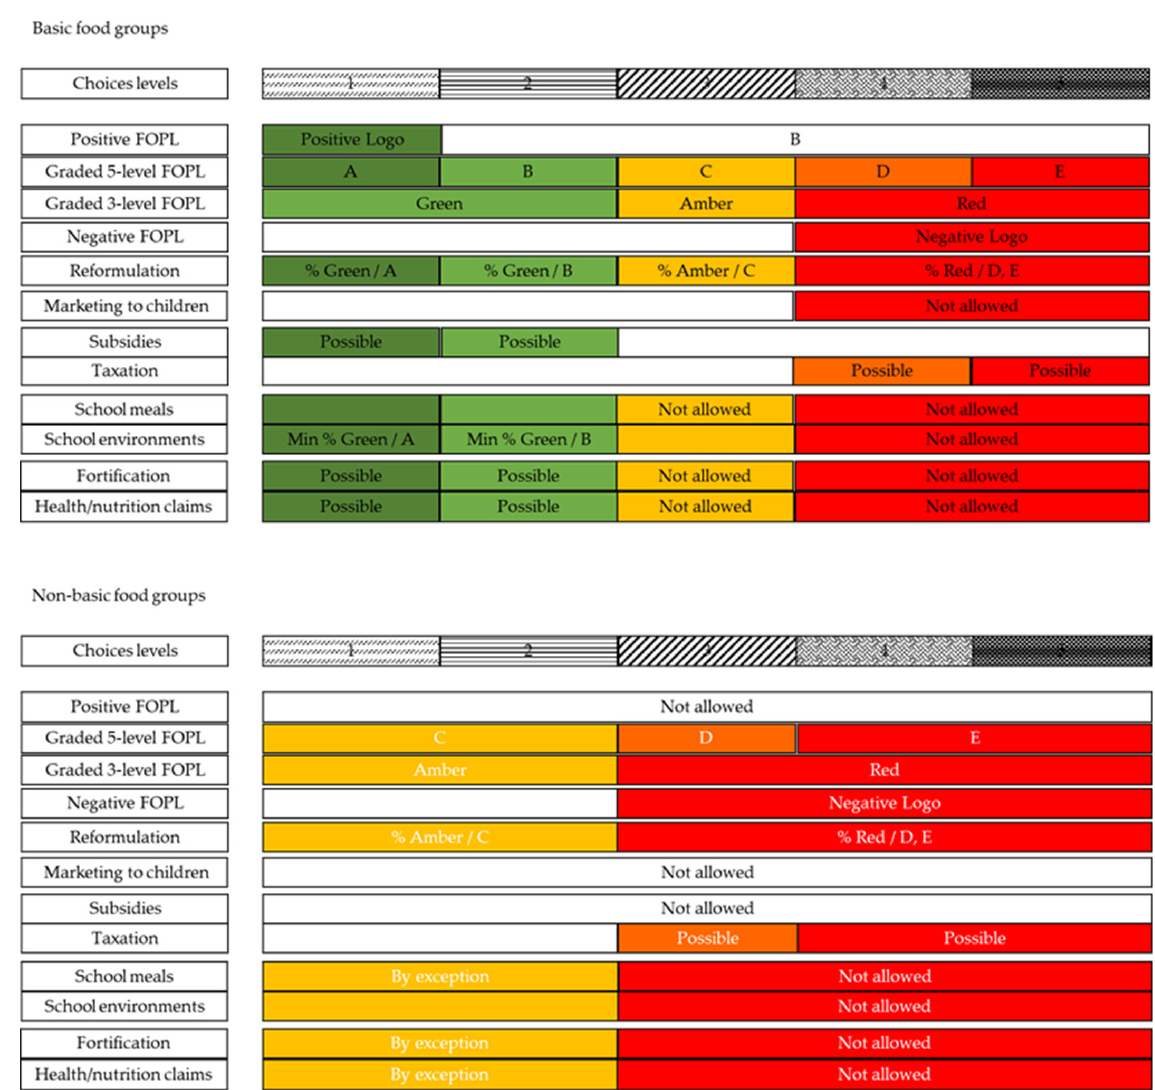
Figure 2. Recommended application of Choices five-level criteria for basic and non-basic food groups, to support multiple food system actions. FOPL = front-of pack label.